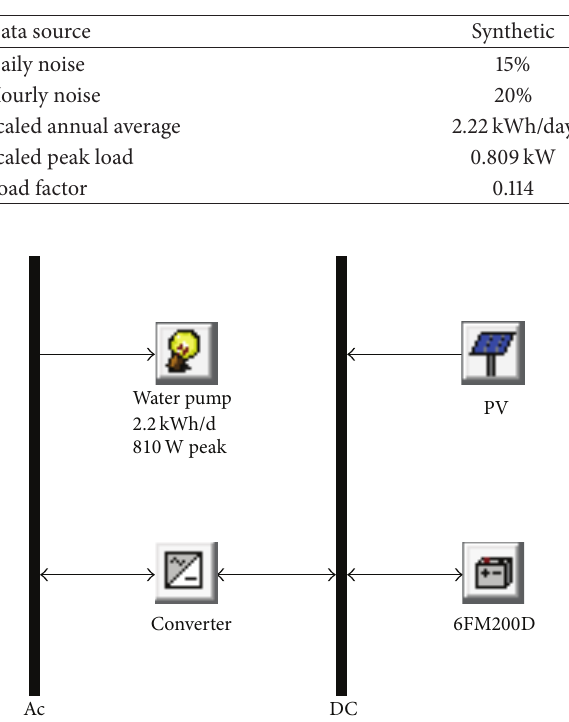
Table 3: Scaled data for simulation.